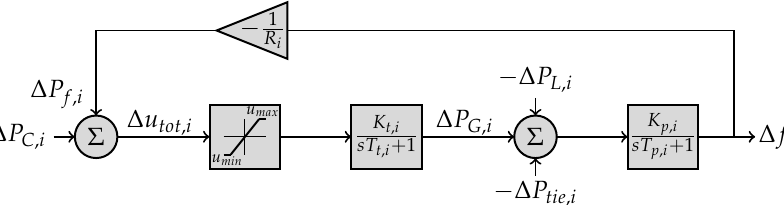
Figure 8. Single block representation of the i -th interconnected area with saturation hard constraint on the total input